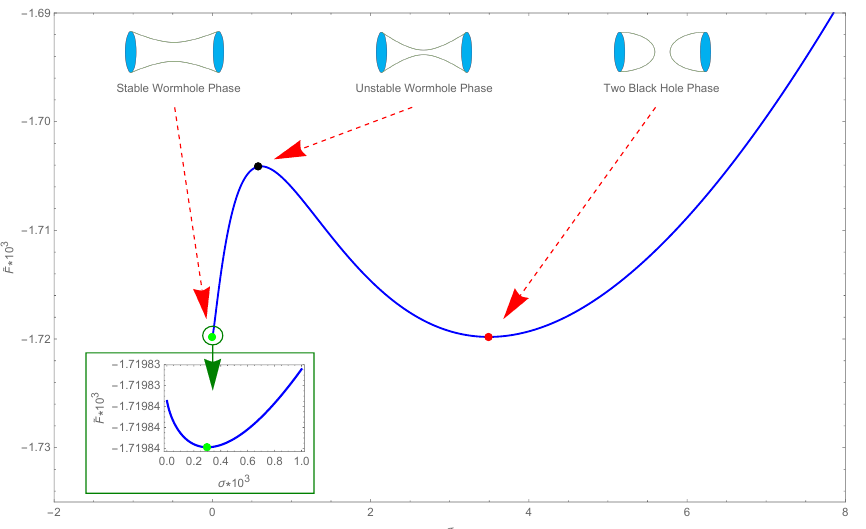
Figure 5 . Free energy landscape, i.e. the off-shell free energy as the function of the order parameter σ . The sub-figure shows the potential well near σ = 0 . It is shown that the landscape has the shape of the double well and three saddle points representing the wormhole phases and two black hole phase. In this plot, q = 50 , J = 1 , ˆ µ = 0 . 1 , and T = 0 . 000753